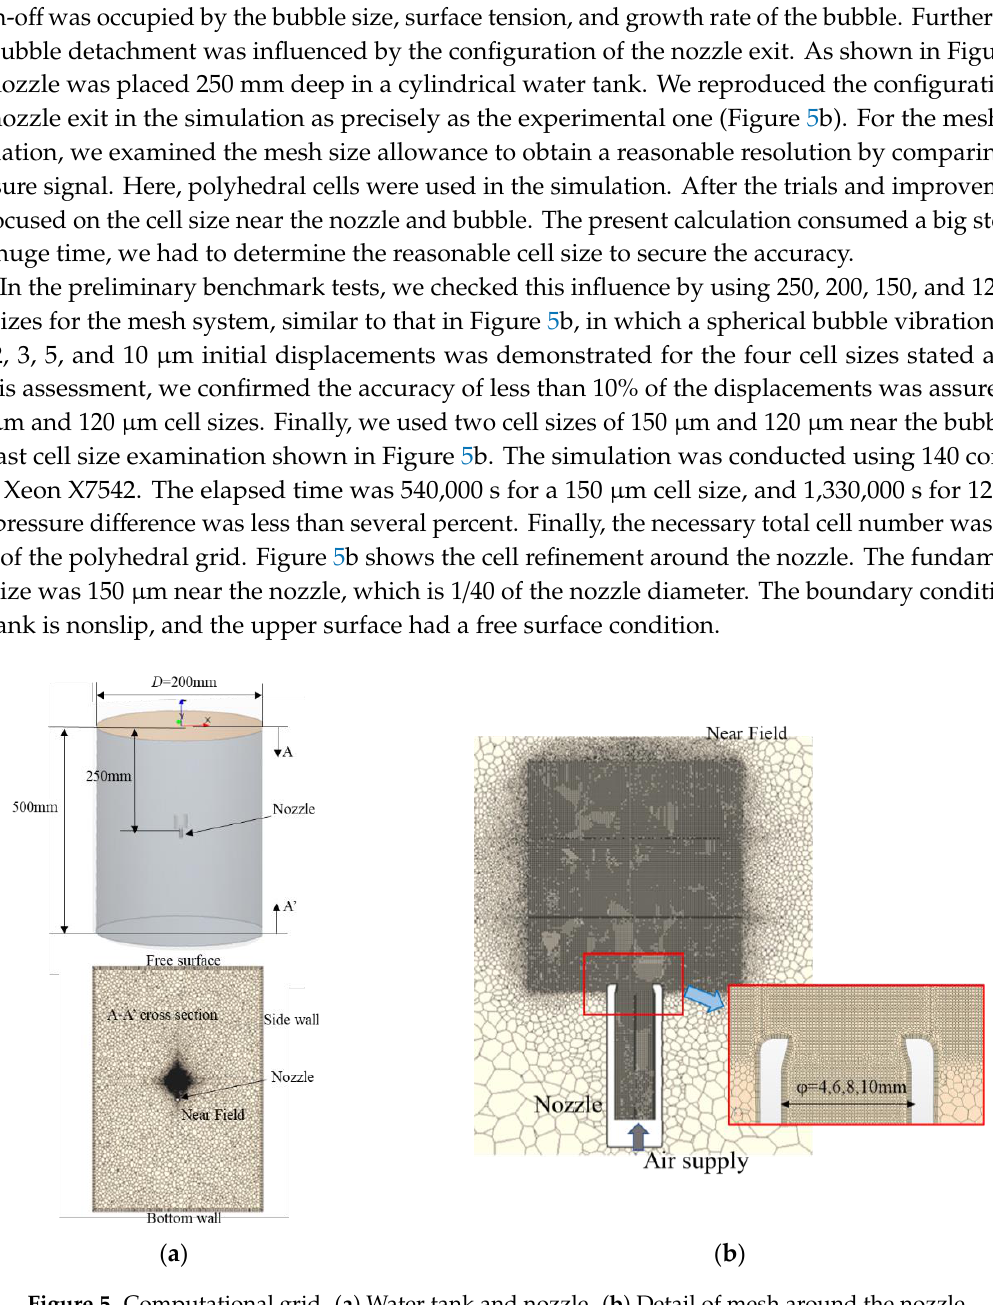
Figure 5. Computational grid. ( a ) Water tank and nozzle. ( b ) Detail of mesh around the nozzle.